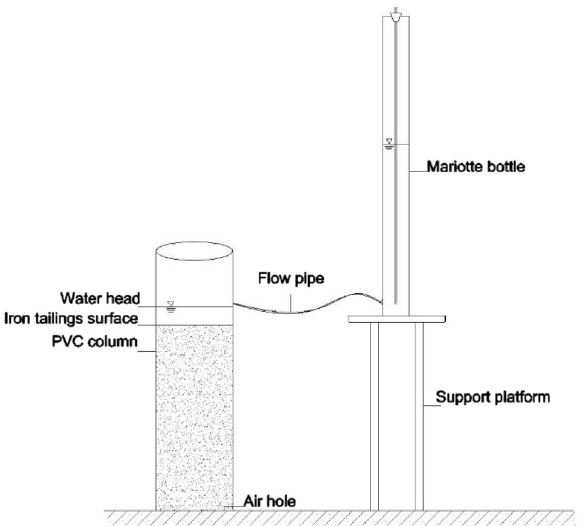
Figure 10. Schematic diagram of experimental setup of water